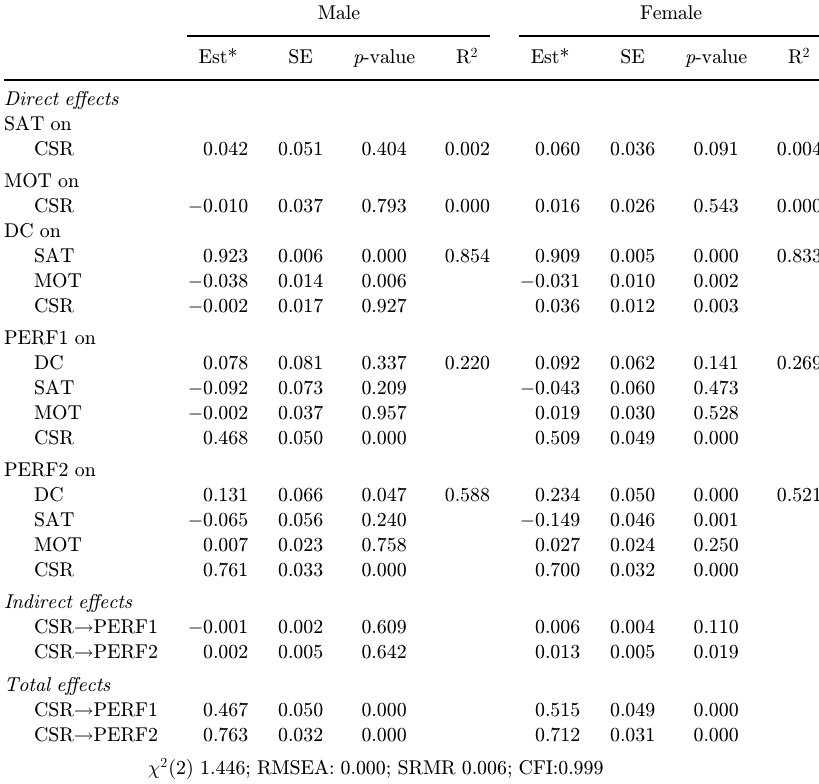
Table B.2. Results of the structural equations model. Covariate: